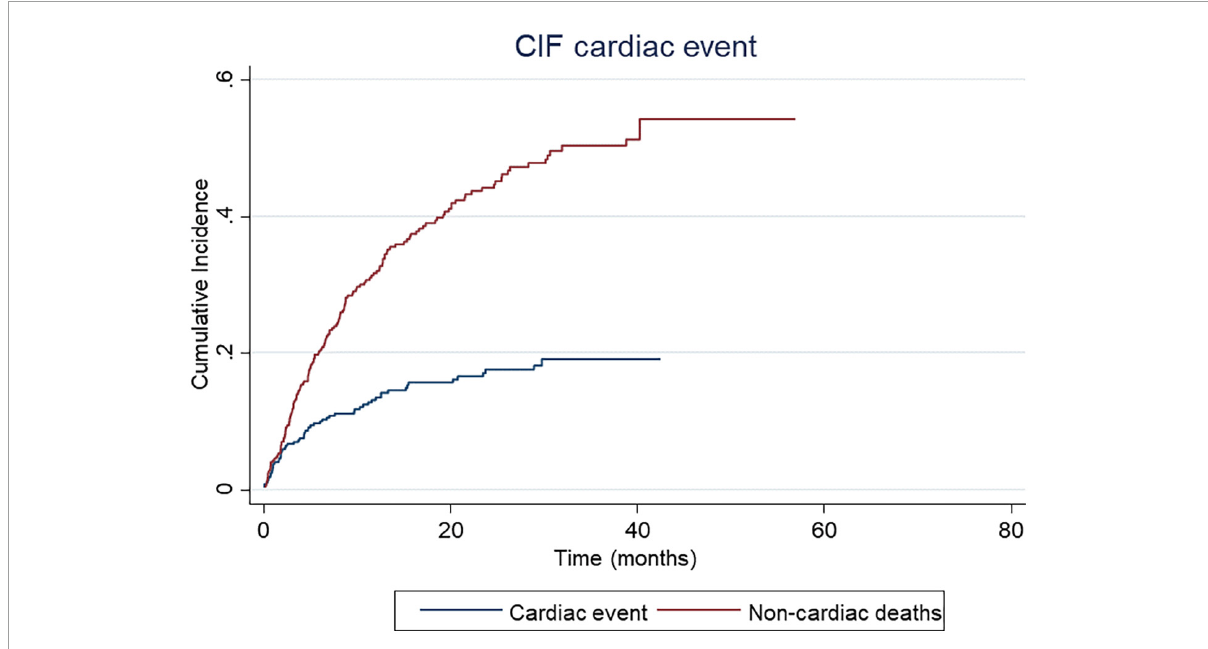
FIGURE1 Cumulative Incidence Function (CIF) of cardiac